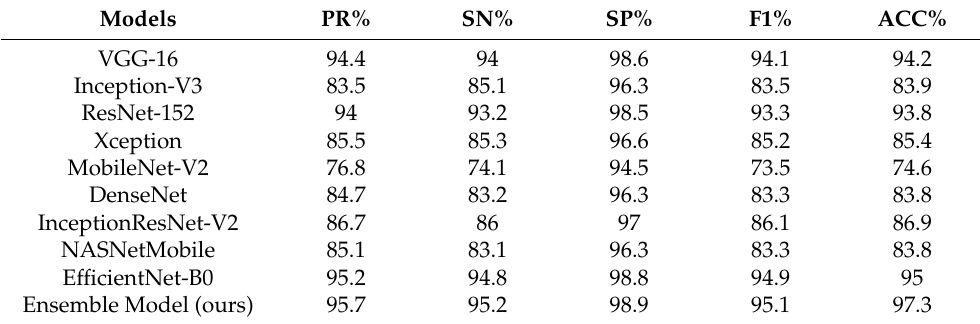
Table 6. Performance comparison between the ensemble model and other fine-tuned